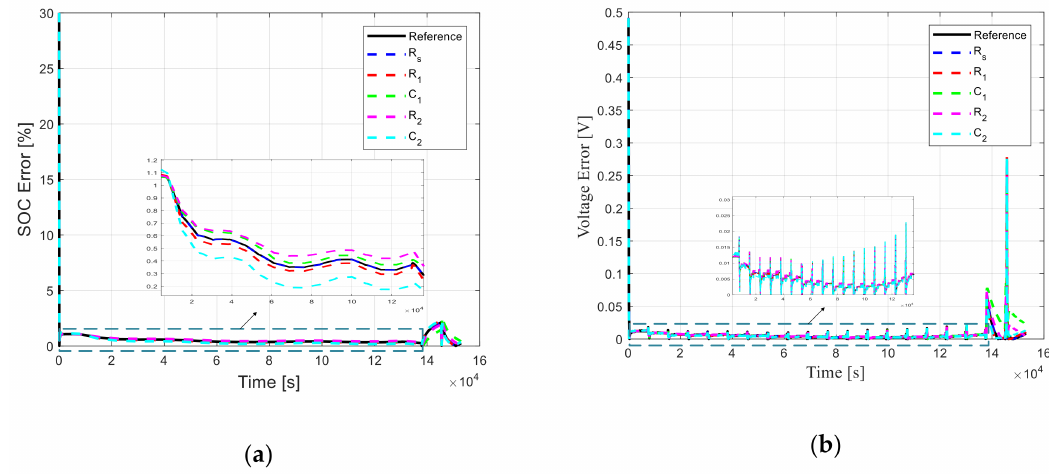
Figure 14. Estimation error curves at 25 ◦ C obtained during sensitivity analysis in terms of: ( a ) SOC; ( b )